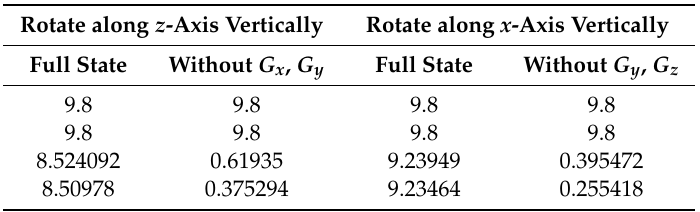
Table 10. SVD of Non-orthogonal